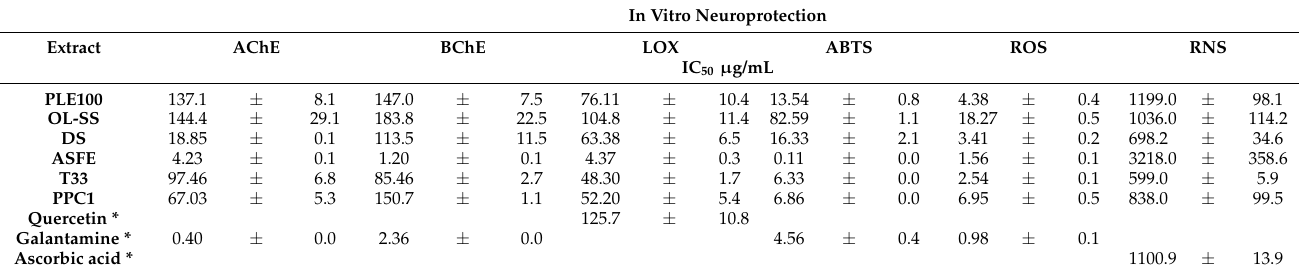
Table 1. IC 50 values from in vitro neuroprotective assays: anticholinesterase (AChE and BChE), anti-inflammatory (LOX), and antioxidant (ABTS, ROS, and RNS) activities. In Vitro